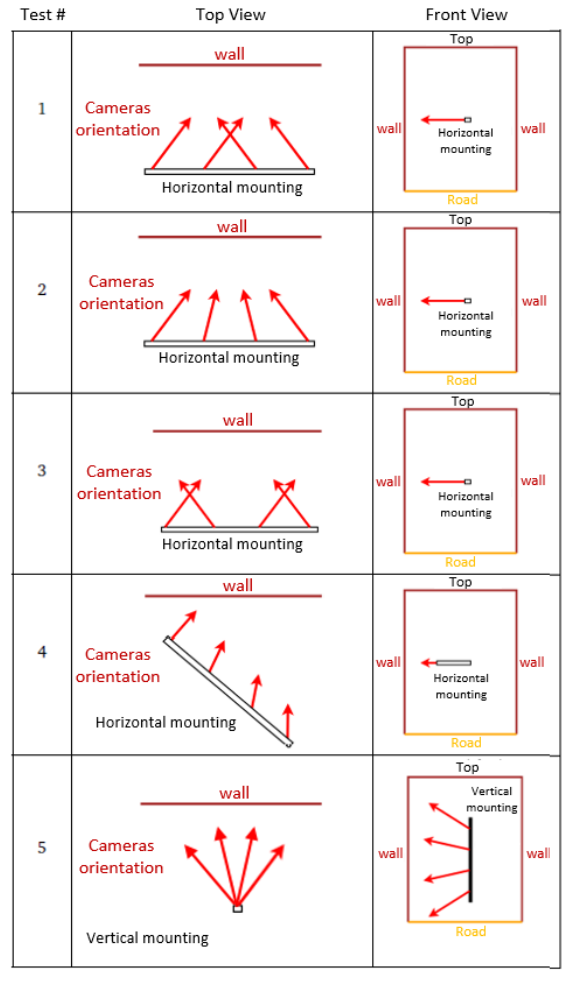
Fig. 2: Available test configurations